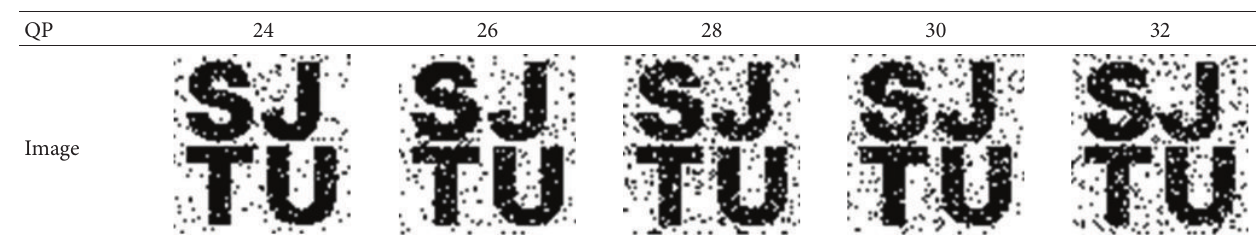
Table 7: Watermark images detected from “Flower” after lossy compression